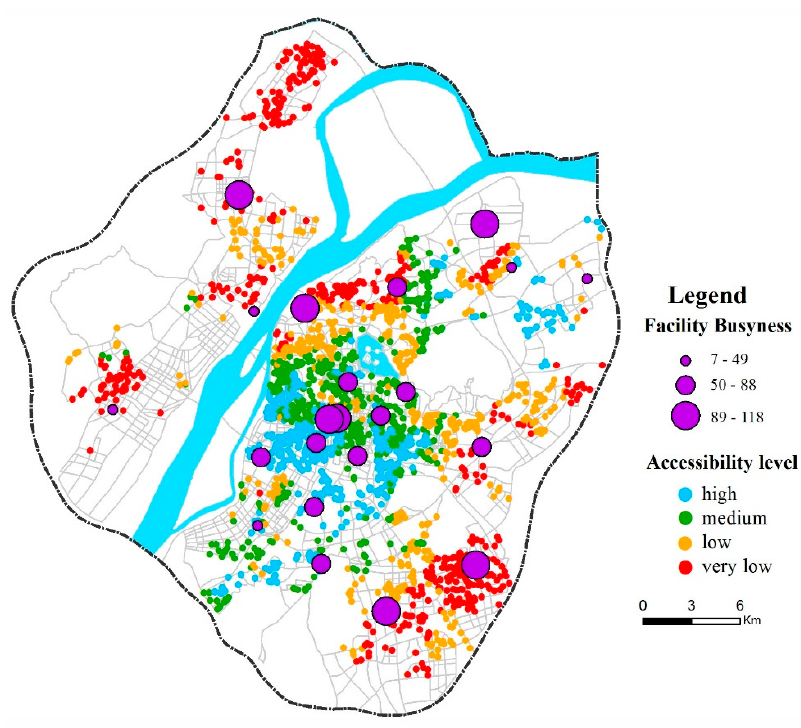
Figure 7. Fire facility busyness and residential quarter accessibility score across the whole study area (based on 5-min catchment).